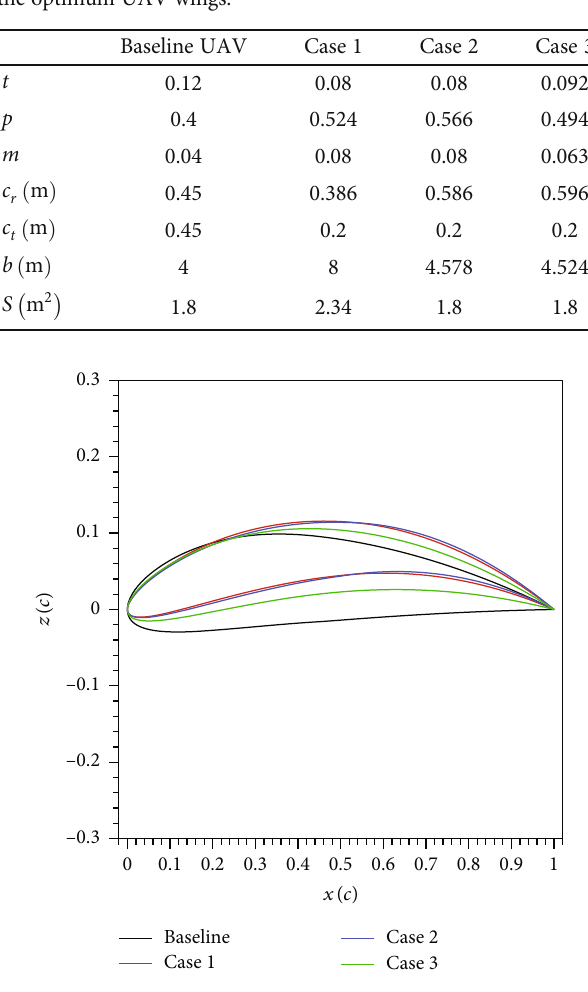
Figure 13: The airfoils of the baseline UAV and the optimum UAV wings.